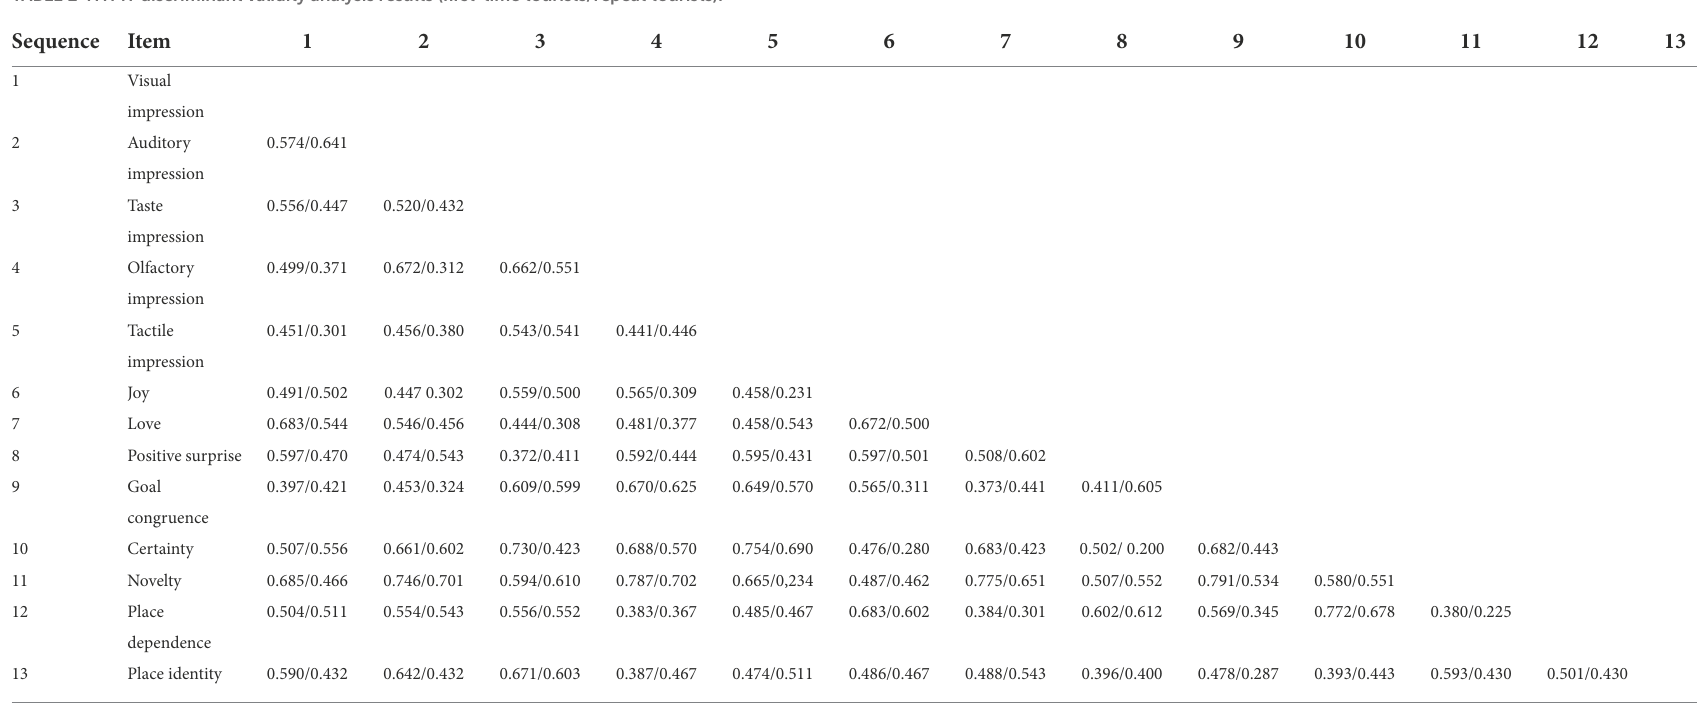
TABLE 2 HTMT discriminant validity analysis results (first-time tourists/repeat